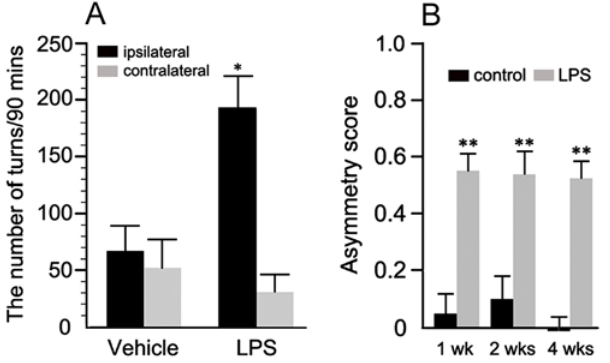
Figure 4. Behavioral deficits following intrastriatal LPS. (A) Ipsilateral rotational behavior in the unilateral LPS-injected animals is significantly increased relative to vehicle-treated animals when amphetamine was administered (n=5–6/group; * p , 0.05). (B) The cylinder test revealed that asymmetric forelimb use is increased significantly after intrastriatal LPS and was sustained for four weeks (n=5–6/group; ** p , 0.01).